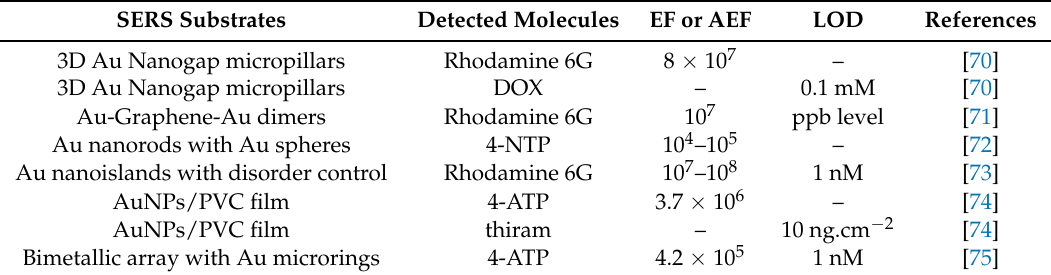
Table 1. Surface enhanced Raman scattering (SERS) performances of substrates designed by self-assembly for biological/chemical sensing (LOD = limit of detection; DOX = doxorubicin; 4-ATP = 4-aminothiophenol; PVC = polyvinyl chloride; 4-NTP = 4-nitrothiophenol). SERS Substrates Detected Molecules